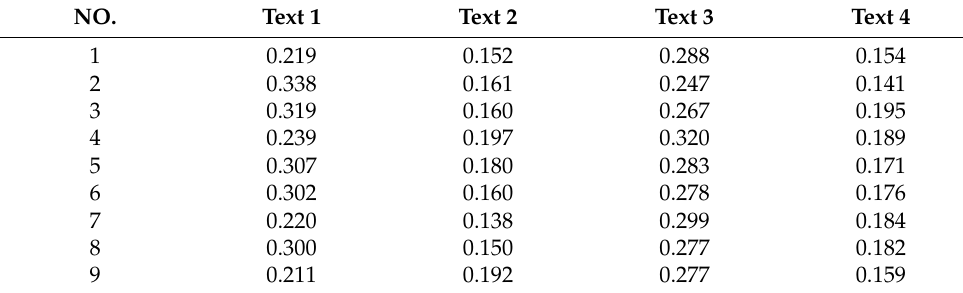
Table 4. Surface roughness experimental results.